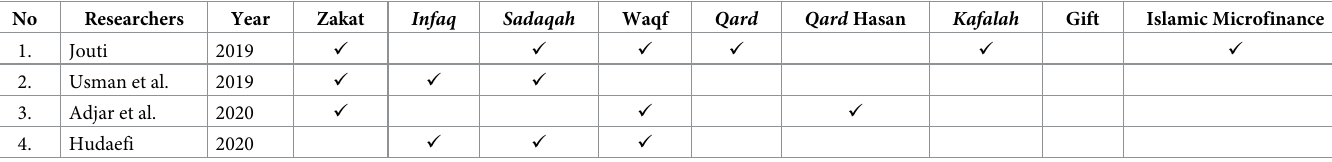
Table 1. Instruments of Islamic social